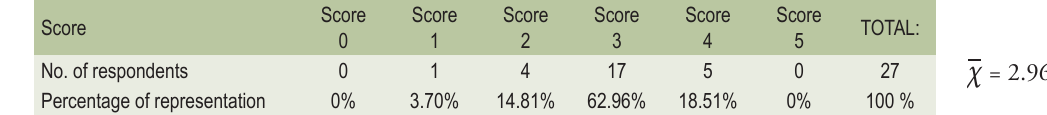
TABLE 5. Condition of respondents before treatment - Acute lumbar pain syndrome